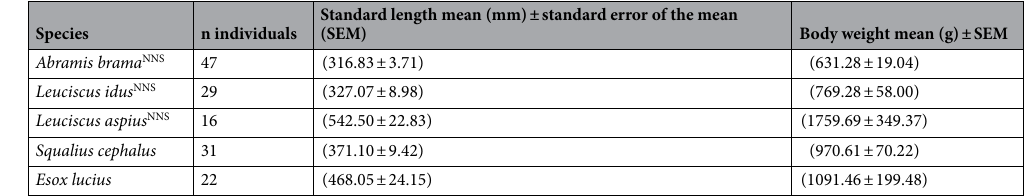
Table 1. Fish used for radiotelemetry tracking. NNS Non-native